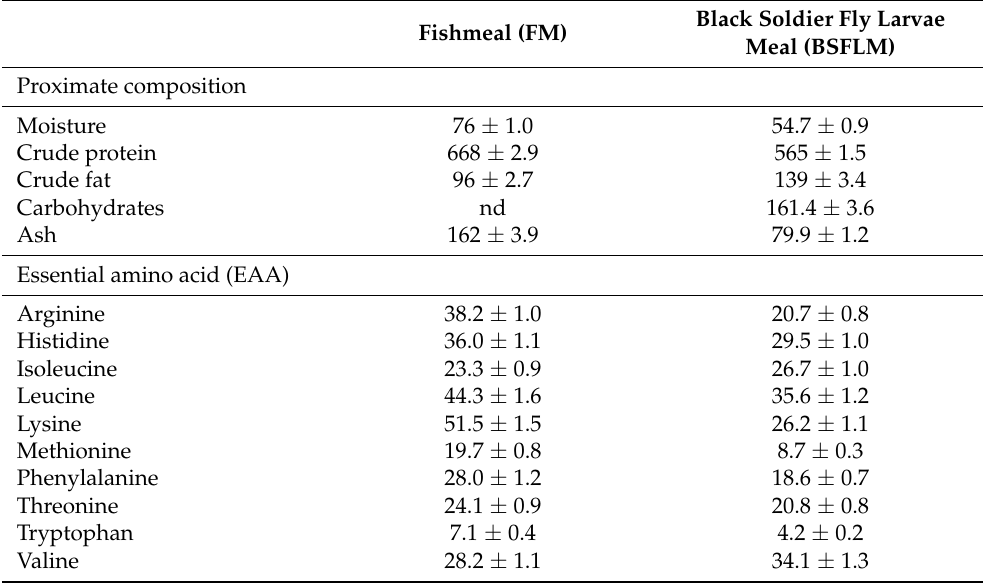
Table 2. Proximate composition and amino acid profiles of fishmeal (FM) and black soldier fly larvae meal (BSFLM) (g kg − 1